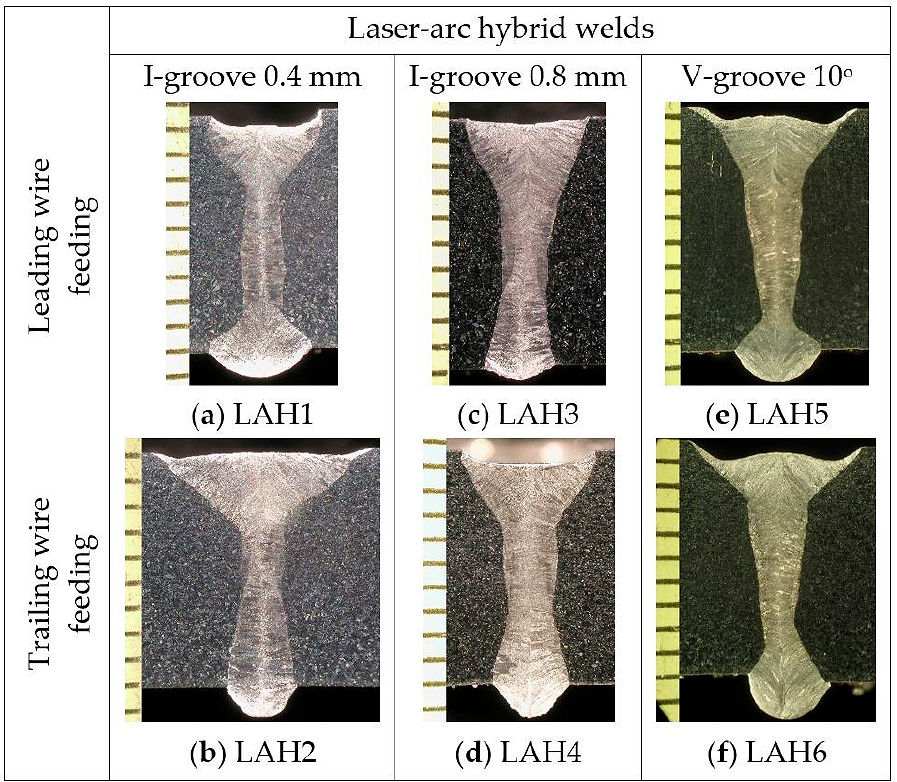
Figure 7. Weld cross-sections ( a – f ) from laser-arc hybrid welding tests.